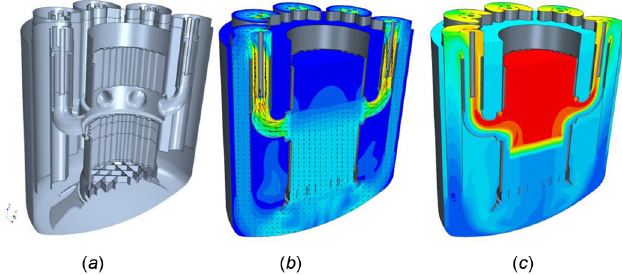
Fig. 6. ALFRED according to LEADER project. Geometry (a), velocity fi eld (b) and temperature fi